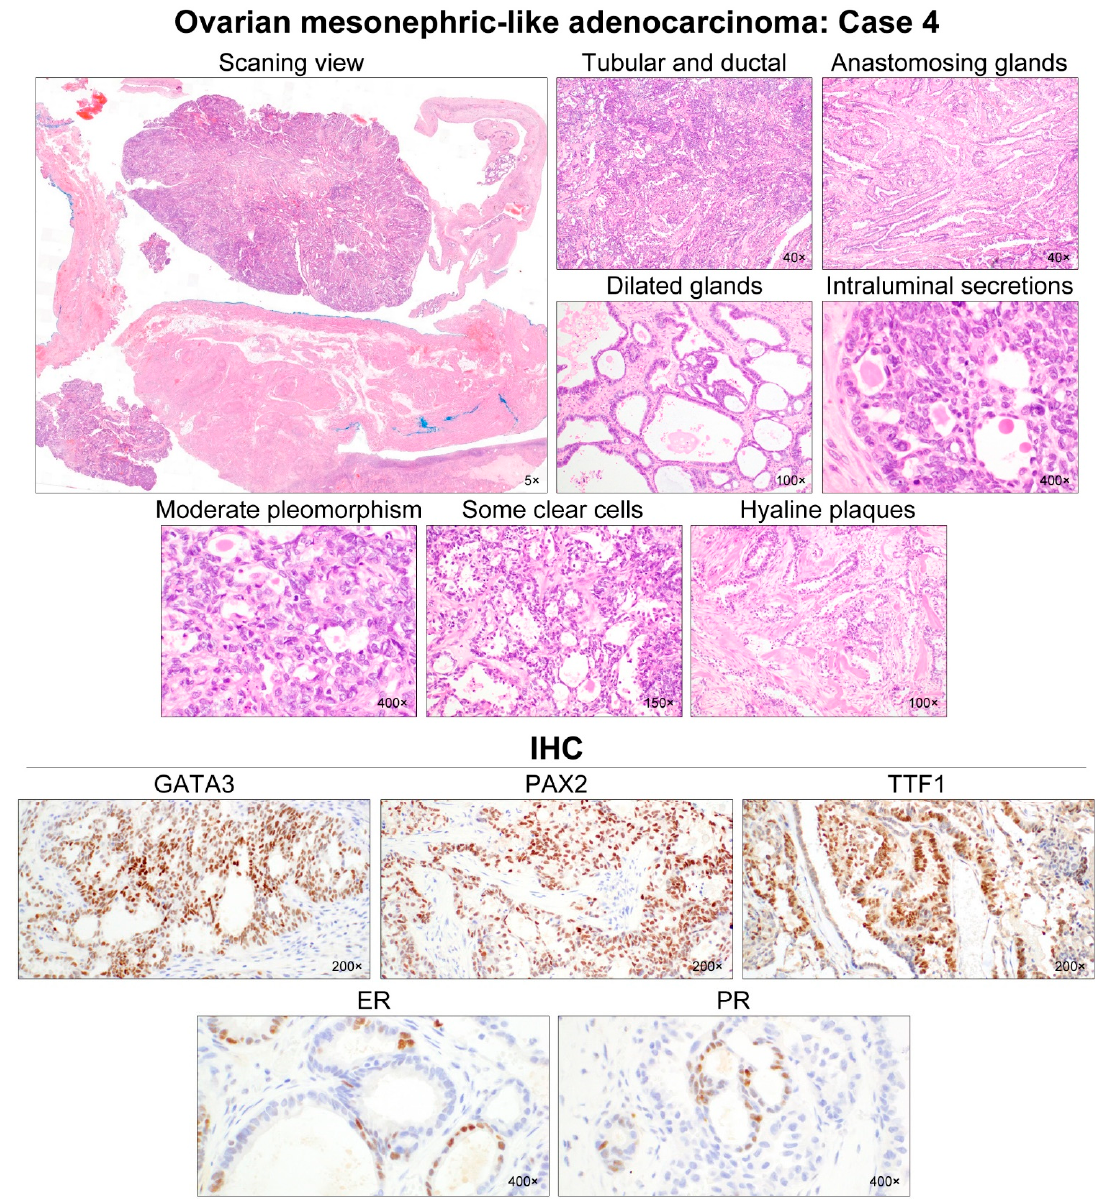
Figure 5. Histological features of ovarian MLA: Case 4. The ovarian mass was solid and cystic, with mural nodules protruding into the cystic lumen. The cystic wall consisted of fibromuscular connective tissue, whereas the solid mural nodules were composed of adenocarcinoma. Two predominant growth patterns were tubular and ductal. Small tubules were compactly aggregated and admixed with inter-anastomosing glands. Cystically dilated glands were often seen. Hyaline-like intraluminal substances were frequently identified in the tubules and glands. The tumor cell nuclei exhibited mild-to-moderate pleomorphism. In addition, angulated ductal structures traversed by thick bands of hyaline collagen were observed. In a few foci, some tubules lined by a few layers of cuboidal or hobnail cells with clear cytoplasm raised the possibility of clear cell carcinoma (CCC). However, severe nuclear pleomorphism, prominent nucleoli, and myxoid stromal cores, characteristic of CCC, were absent. The tumor cells were strongly positive for GATA3, PAX2, and TTF1. We noted that some tumor cells were positive for ER and PR, with moderate staining intensity. Although hormone receptor immunoreactivities were not typical of MLA, previous data indicated that this unusual expression pattern did not preclude the diagnosis of